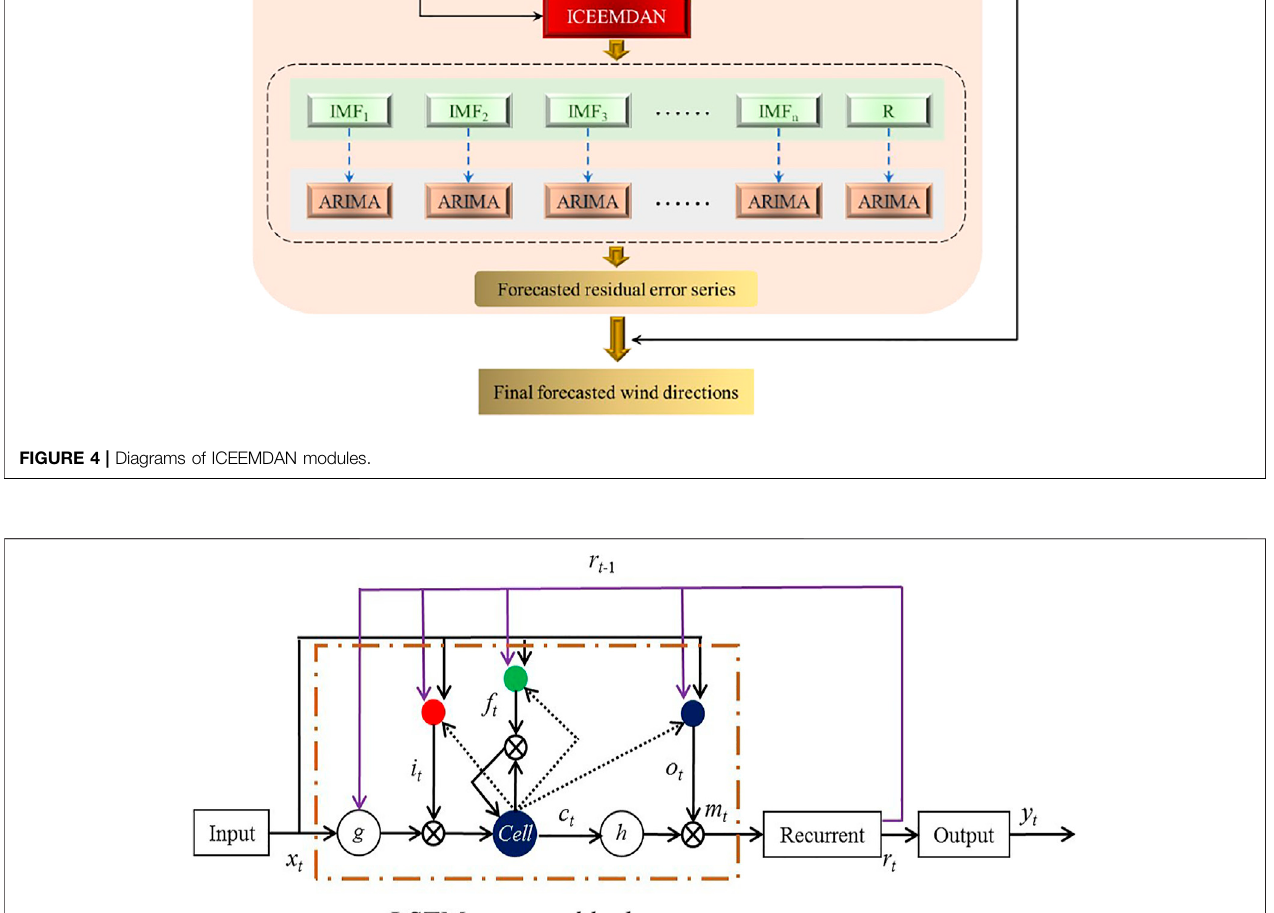
Frontiers in Energy Research |